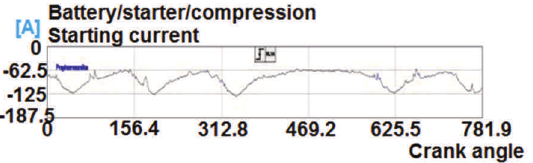
Fig. 10. Starting current with one spark plug removed